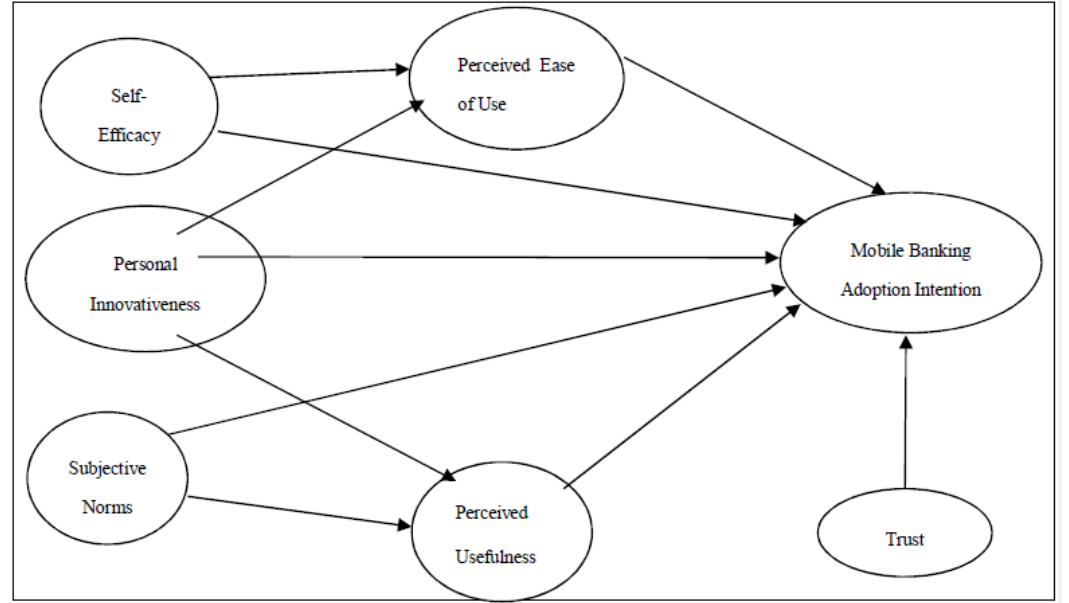
Figure 1. Conceptual Mobile Banking Adoption Intention Model.